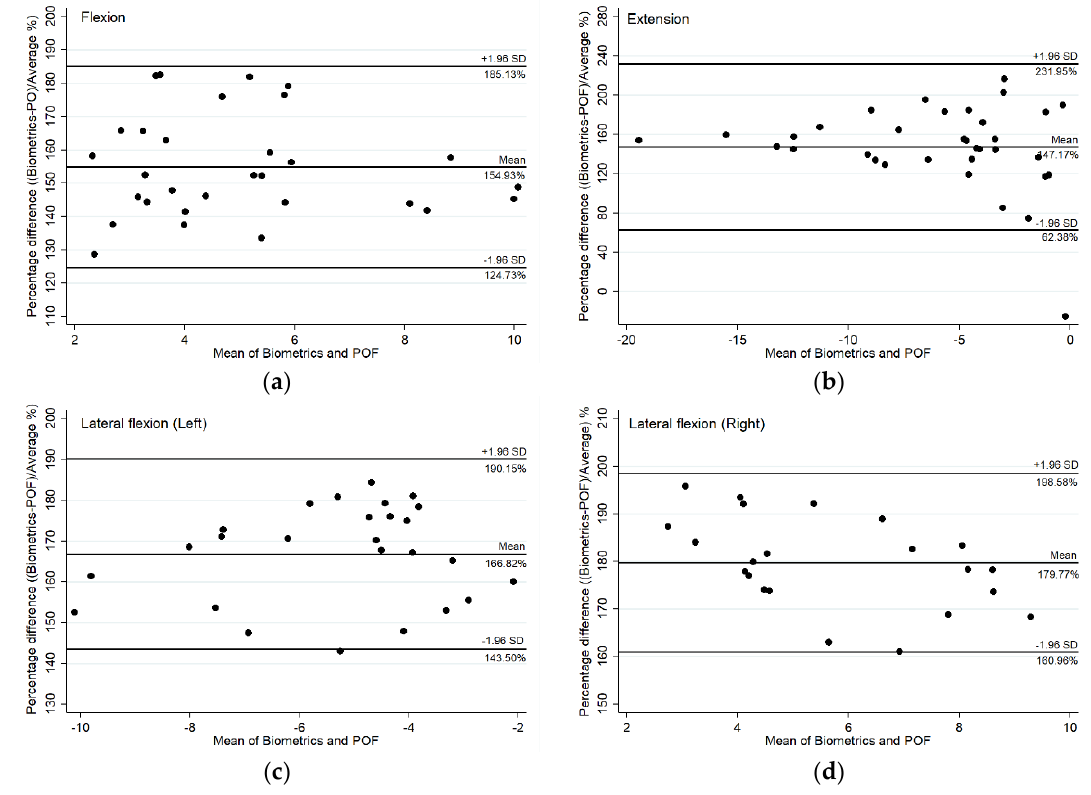
Figure 5. Bland–Altman plots between the POF sensor and Biometrics goniometer showing mean and percentage differences with the 95% limits of agreement (LOA) for each movement including ( a ) flexion, ( b ) extension, ( c ) left lateral bend and ( d ) right lateral bend.